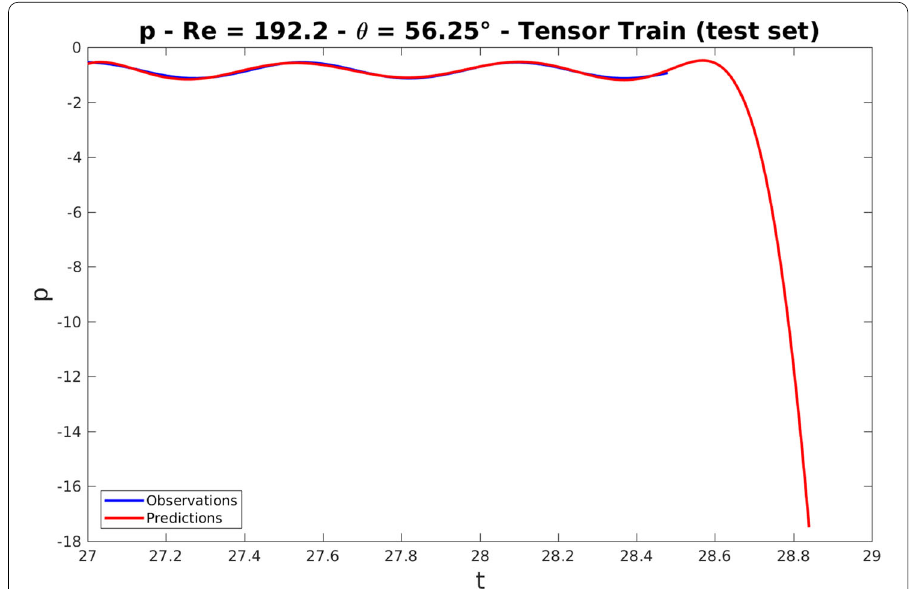
Fig. 3 Low Reynolds numbers. Observations and predictions with respect to time for fixed values of the other parameters. The predictions are obtained using tensor formats combined with changes of variables (unconstrained)